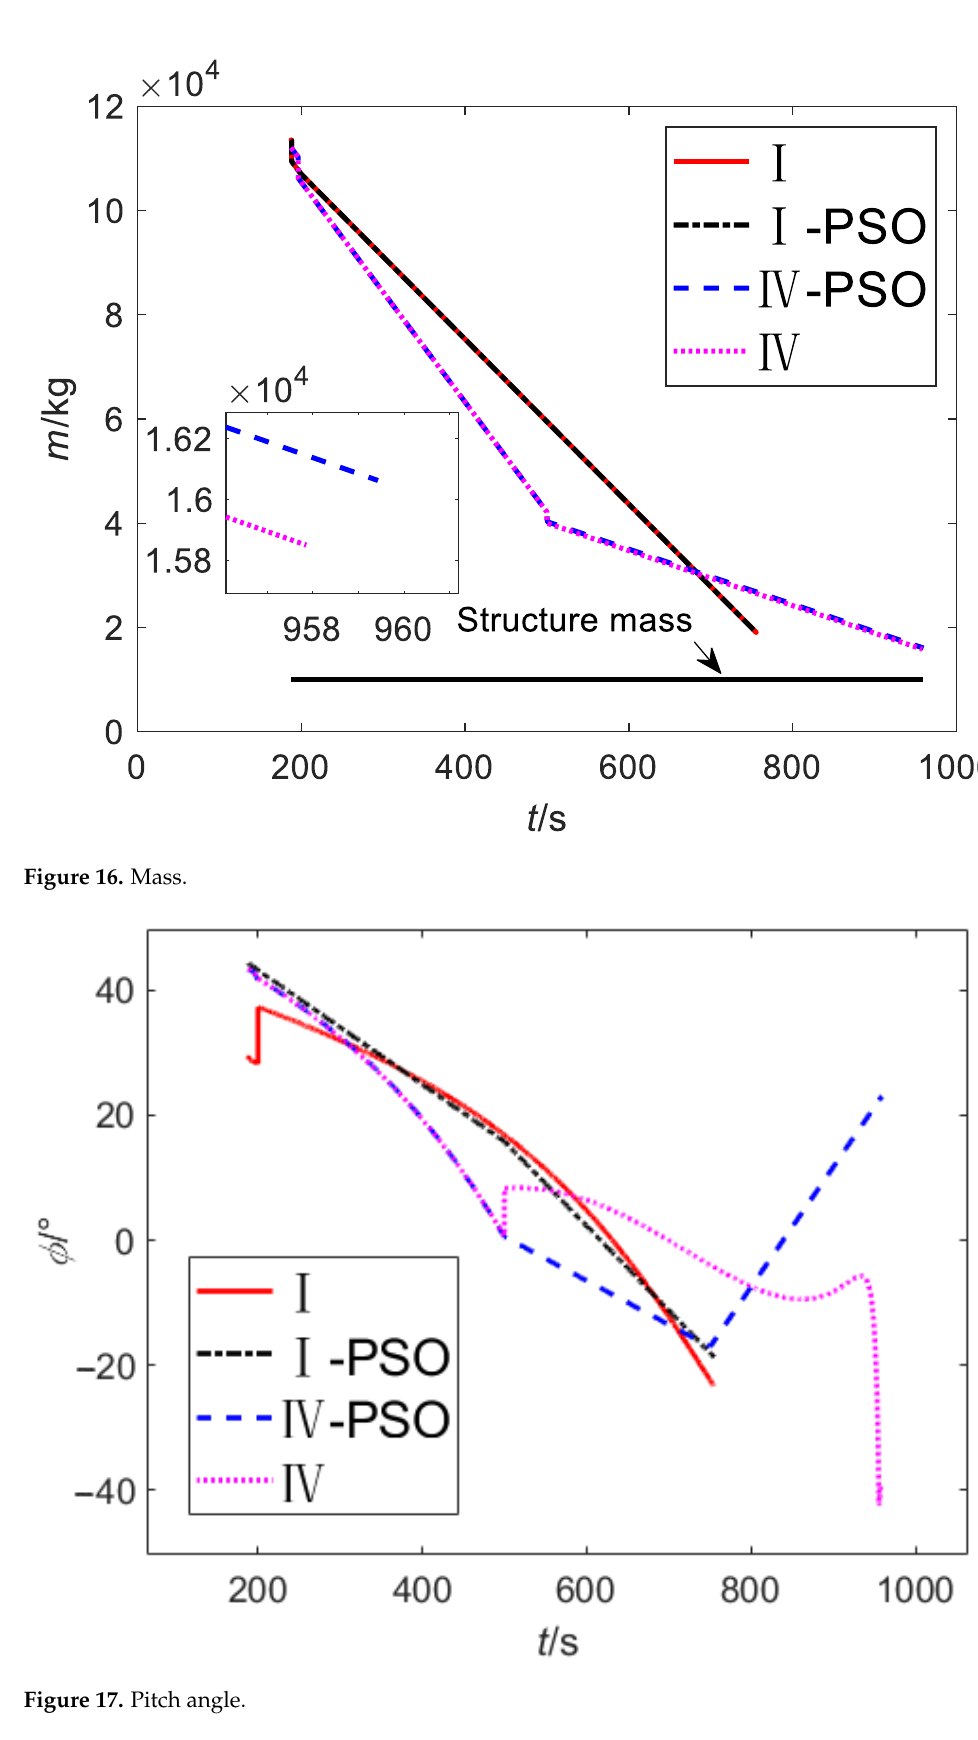
Table 5. Effectiveness results of mission decision making and trajectory planning.